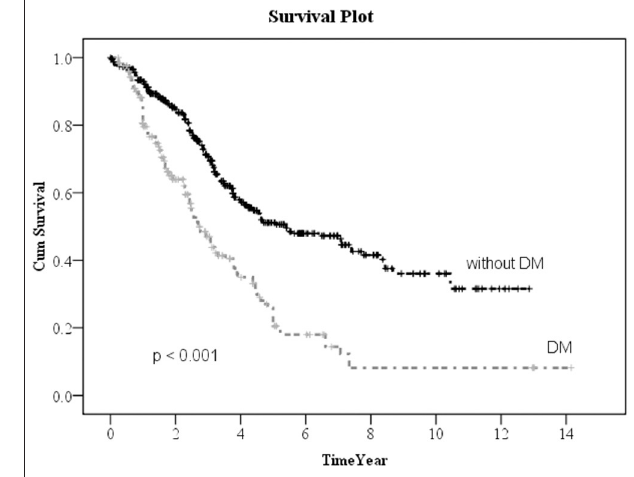
FIGURE 2 | The survival pot of PD catheter in all patients. PD, peritoneal dialysis.